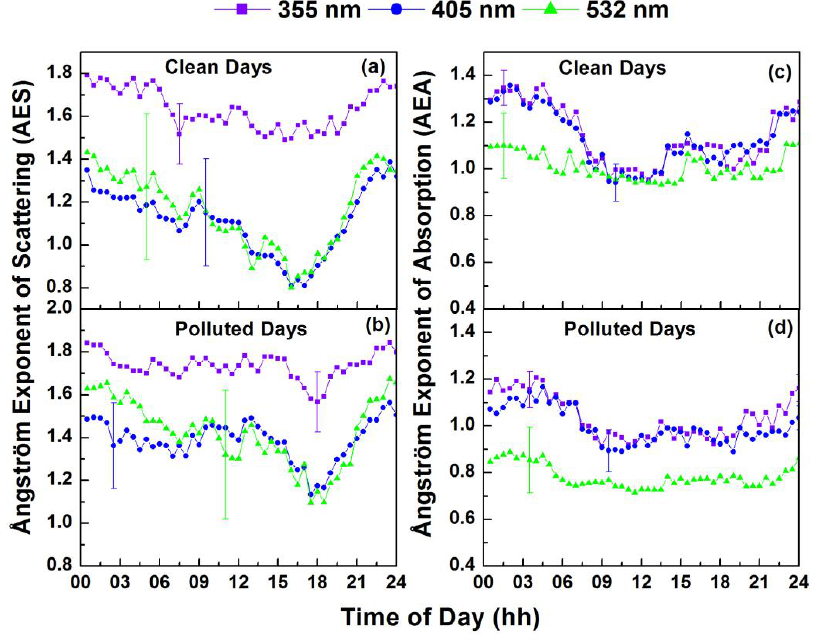
Fig. 7. Diurnal variation of half-hour average ambient intensive aerosol optical properties for clean and polluted days from 18 December 2009 to 18 January 2010 at wavelengths 355, 405, and 532nm using 870nm as a reference. (a) and (b) ˚Angstr¨om exponent of scattering (AES), (c) and (d) ˚Angstr¨om exponent of absorption (AEA). Uncertainty on AES and AEA were determined by assuming 5% relative uncertainty in photoacoustic absorption coefficient measurements and 15% relative uncertainty in scattering coefficient